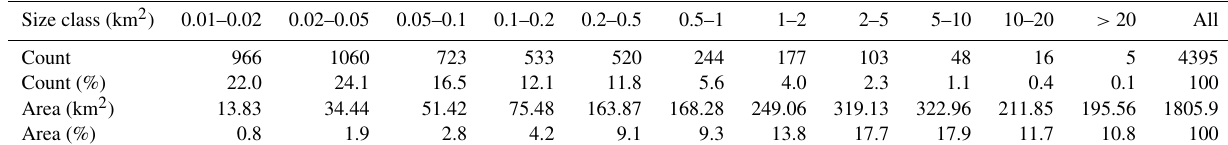
Table 2. Glacier area and count per size class for the entire sample.